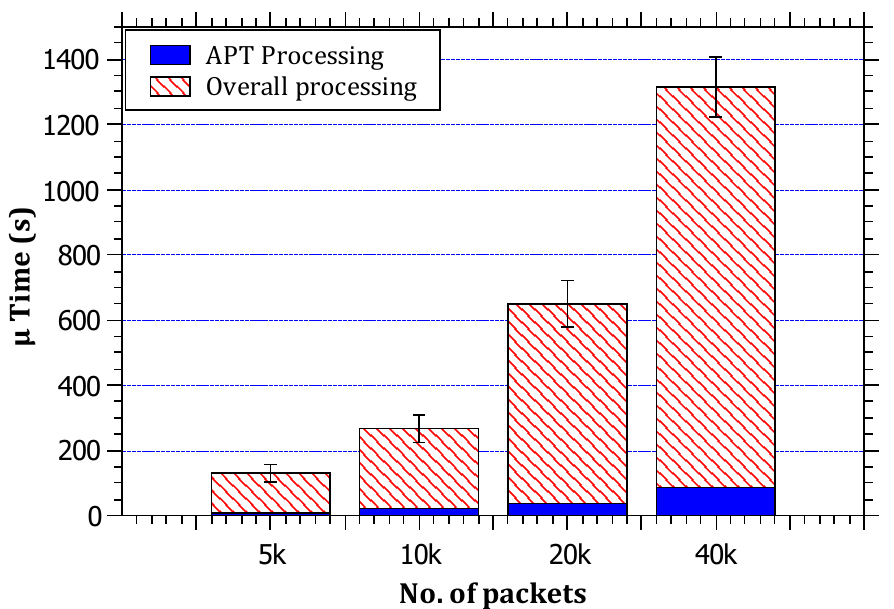
Figure 7. The relationship between the amount of traffic and the ratio of RAPT algorithm processing time to the total simulation processing